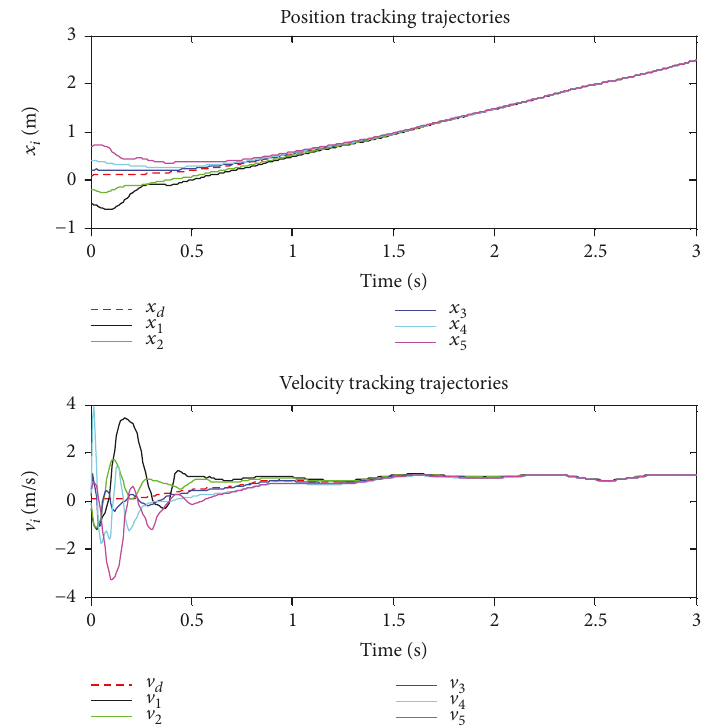
Figure 2: State tracking trajectories for Case